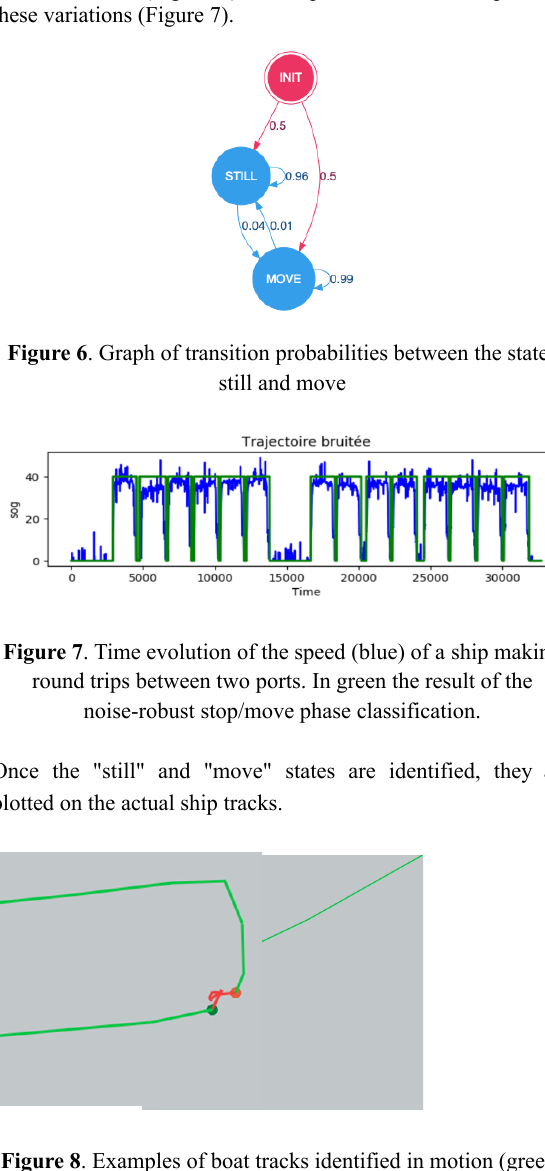
Figure 8 . Examples of boat tracks identified in motion (green) and at rest (red) by ARLAS PROCML. On the left, we recognise the red trace of a boat held by an ink.